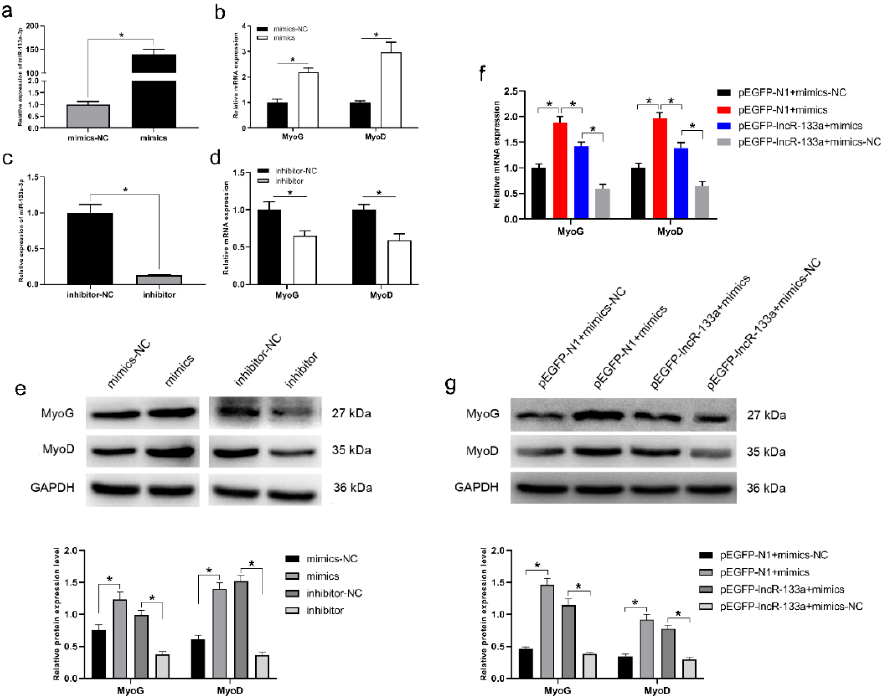
Figure 4. MiR-133a-3p promotes MuSC differentiation. ( a ) The expression level of miR-133a-3p was measured in MuSCs transfected with miR-133a-3p mimics (mimics) or mimics negative control (mimics-NC). ( b ) The expression levels of MyoG and MyoD were determined in MuSCs transfected with miR-133a-3p mimics or mimics-NC. ( c ) The expression level of miR-133a-3p was measured in MuSCs transfected with miR-133a-3p inhibitor (inhibitor) or inhibitor negative control (inhibitor- NC). ( d ) The expression levels of MyoG and MyoD were determined in MuSCs transfected with miR-133a-3p inhibitor or inhibitor-NC. ( e ) The protein levels of MyoG and MyoD were measured in MuSCs transfected with miR-133a-3p mimics or mimics-NC, miR-133a-3p inhibitor or inhibitor-NC. ( f ) The expression levels MyoG and MyoD were determined after treatment with miR-133a-3p mimics and/or pEGFP-lncR-133a. ( g ) The protein levels of MyoG and MyoD in MuSCs transfected with miR-133a-3p mimics and/or pEGFP-lncR-133a. Data are means ± standard error of the mean of at least three biological replicates, * p <